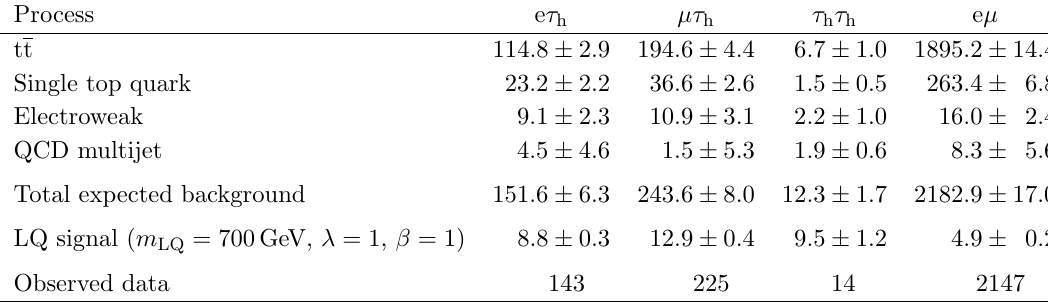
Table 2 . Numbers of events observed in the e (cid:28) h , (cid:22)(cid:28) h , (cid:28) h (cid:28) h , and e (cid:22) channels for S T > 500 GeV, compared to the background expectations and to the event yield expected for single-LQ processes with m LQ = 700 GeV ( (cid:21) = 1 and (cid:12) = 1). The \electroweak" background contains the contributions from W+jets, Z+jets, and diboson processes. The uncertainties represent the sum in quadrature of statistical and systematic contributions, and are obtained using the binned maximum likelihood (cid:12)t of the S T